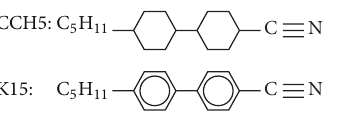
Figure 2: Structure formulas of the liquid crystal molecules CCH5 and K15.